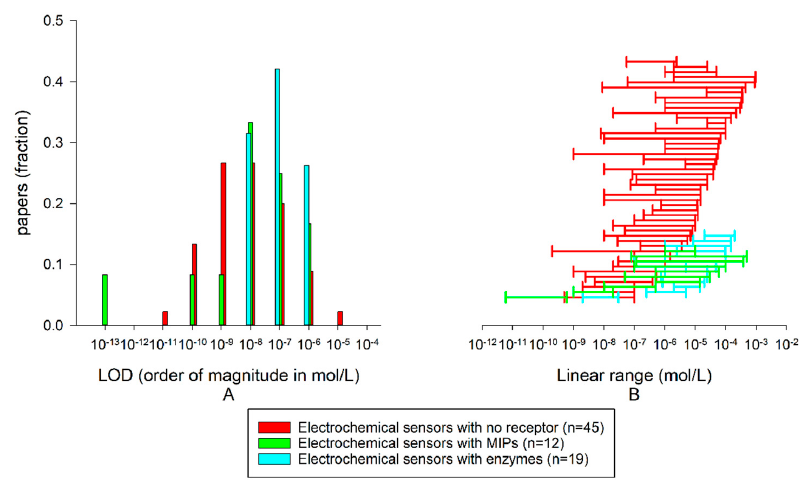
Figure 20. ( A ) distribution of LODs of electrochemical sensors in the papers examined in this review; ( B ) linear response ranges of electrochemical sensors in the papers examined in this review. Other sensing elements as nucleic acids and peptides are found very rarely in electrochemical sensors for phenols, and the few examples do not allow evaluation of their general performance. Coming to optical systems, and including here colorimetric and fluorimetric sensors, although less present in the literature, their detectability to phenolic compounds is comparable to that obtained with electrochemical sensors, with median LODs in the ten nanomolar range. Within optical systems, a comparison can be done between sensors without specific recognition systems and MIP-based ones (See Table 4 and Figure 21).